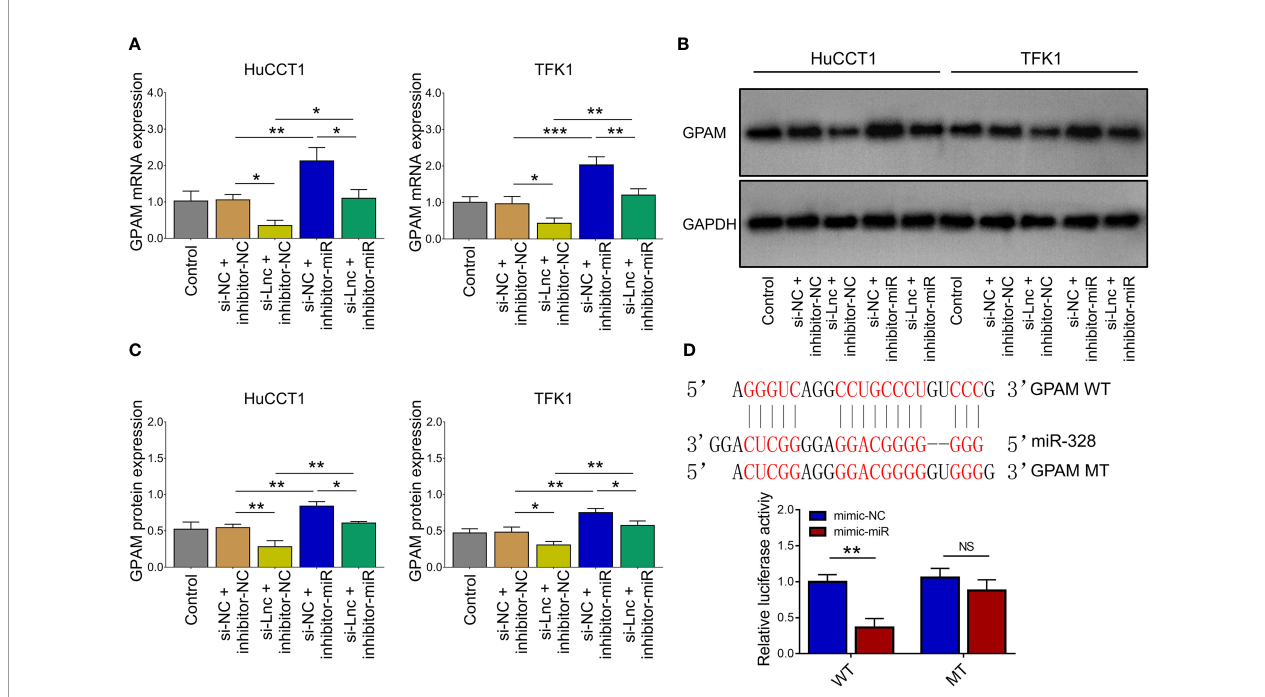
FIGURE 5 | Effect of lnc-PKD2-2-3 knockdown and miR-328 knockdown on GPAM in CCA cell lines. GPAM expression among groups after transfection (A – C) . Relative activity of luciferase gene reporter assay and bound/designed sequences of miR-328 and GPAM (D) . NS, not signi fi cant; * P < 0.05; ** P < 0.01; *** P < 0.001.